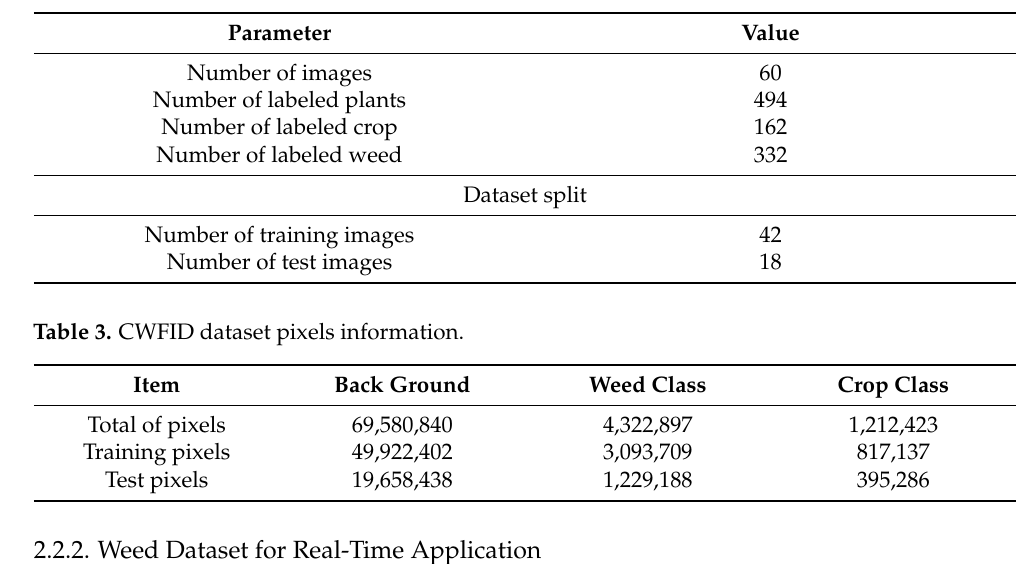
Figure 1. General overview of the model training and inference process carried out in this work. ( A ) Illustrate the collection and preparation of the dataset. ( B ) Show the training process to obtain the base models. ( C ) Show the model optimization. ( D ) Show the deployment on the Jetson Nano device. Table 2. Scope of the CWFID dataset and split.